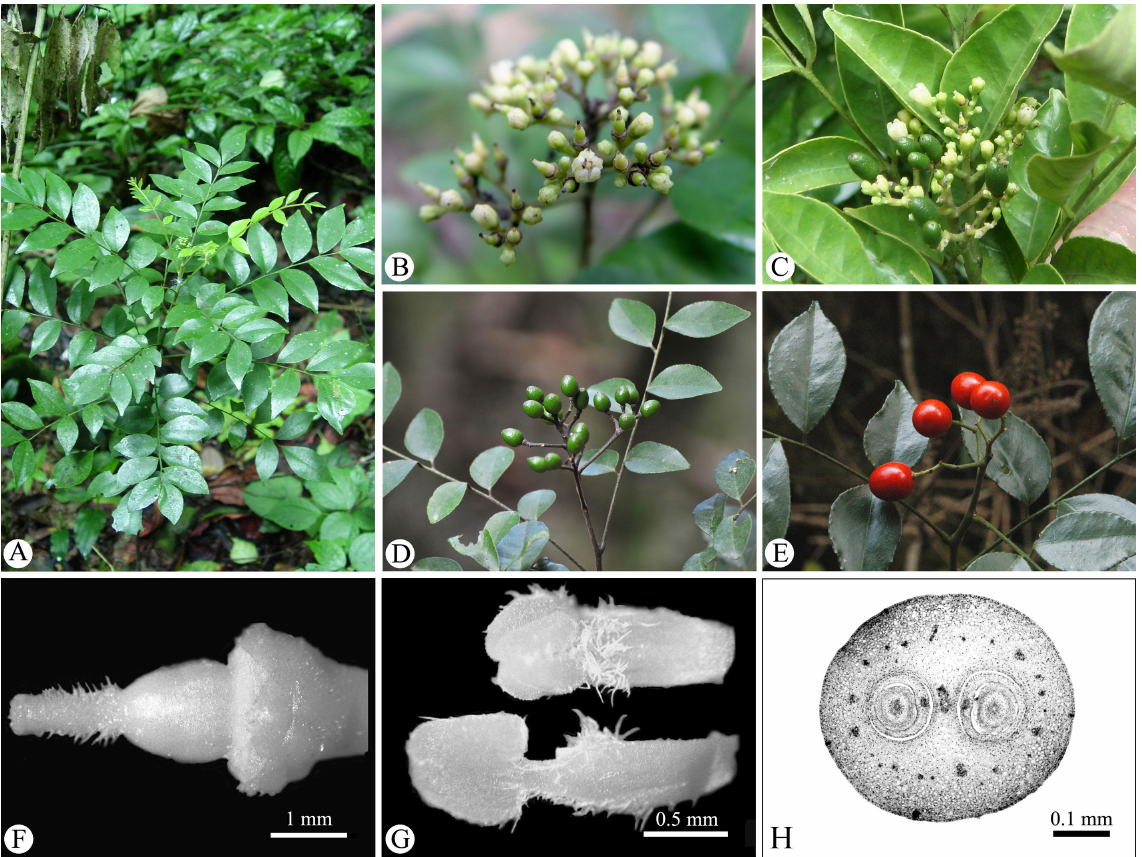
Fig. 8. Bergera kwangsiensis (C.C.Huang) F.J.Mou comb. nov. A. Plant. B . Inflorescence. C . Flowers and young fruits. D–E . Infructescence. F . Pistil. G . Stamens. H . Ovary crossection. Photos taken